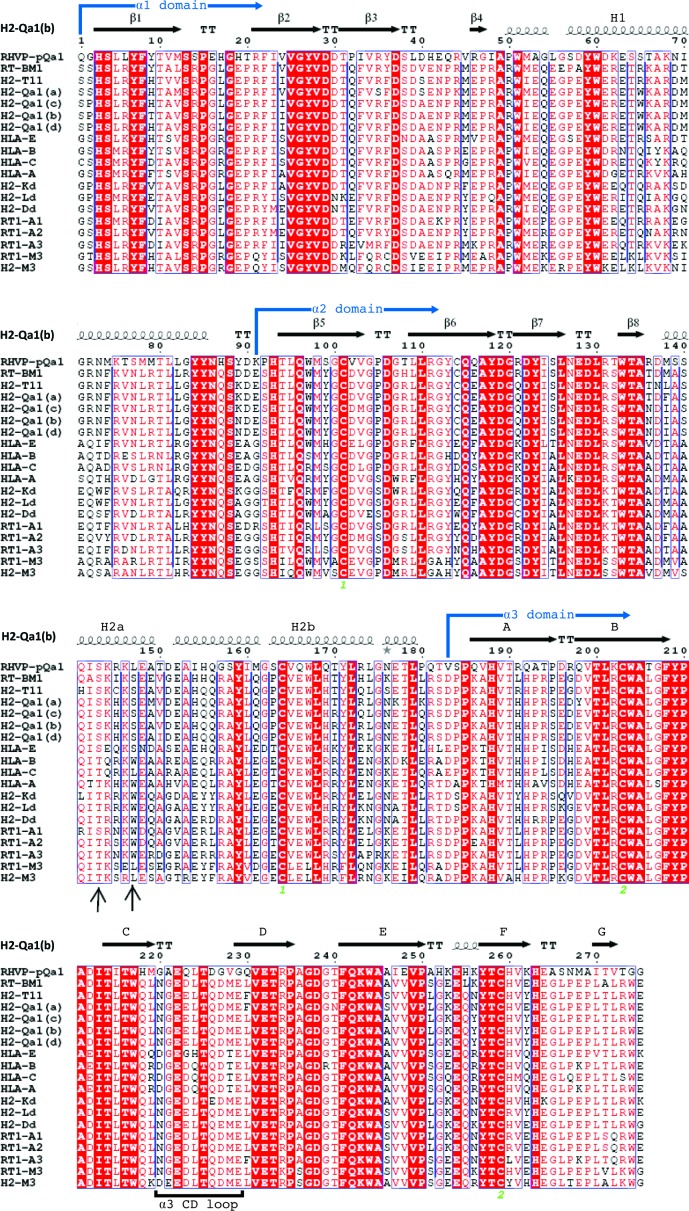
Sequence alignment of pQa-1 with selected classical and non-classical MHC-I proteins.The pQa-1 ectodomain amino acid sequences are compared to closely related MHC-I proteins using ESPript3 (Robert and Gouet, 2014). The secondary structure of mouse Qa-1 is depicted above the alignment and comes from the available crystal structure (PDB:3VJ6). The residues that distinguish Qa-1 from classical MHC-I in the F pocket of peptide binding are indicated by arrows. RT-BM1: rat MHC-Ib-S3 (NP_001008886.2); H2-T11: mouse H2-T11 (NP_001257934); H2-Qa-1(a), -Qa-1(c), -Qa-1(b) and -Qa-1(d): mouse Qa-1a (XP_003945787), Qa-1c (AAD12244.1), Qa-1b (NP_034528) and Qa-1d (AAD31381); HLA-E: human HLA-E (NP_005507.3); HLA-B: human HLA-B7 (AAA91229); HLA-C: human HLA-Cw0702 (CAA05125); HLA-A: human HLA-A2 (ASA47534); H2-Kd: mouse H2-Kd (P01902.1); H2-Ld: mouse H2-Ld (P01897.2); H2-Dd: mouse H2-Dd (P01900.1); RT1-A1: rat MHC-Ia-A1 (NP_001008827.1); RT1-A2: rat MHC-Ia-A2 (NP_001008829); RT1-A3: rat MHC-Ia-A3 (NP_001008830); RT1-M3: rat MHC-Ib-M3 (NP_075210.2); H2-M3: mouse H2-M3 (AAA39597). Conserved cysteine residues involved in disulfide bond formation are marked with green numerals (1 or 2) under the sequence alignment.